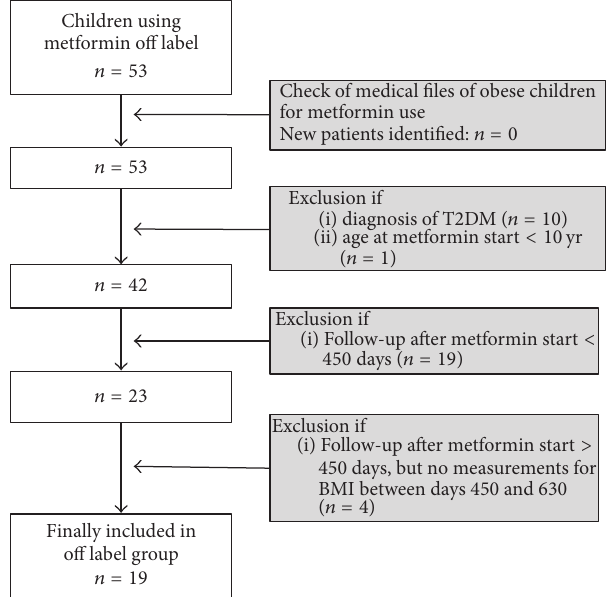
Figure 1: Flowchart of included patients in the daily clinical practice